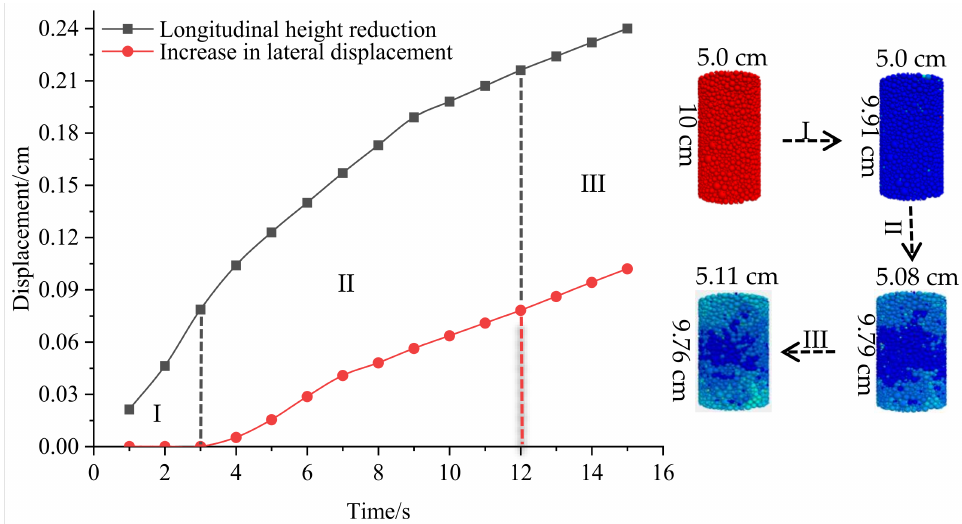
Figure 11. Diagram of compaction stage of sand-gabion (x-axis shows the vibration time, y-axis shows the compaction